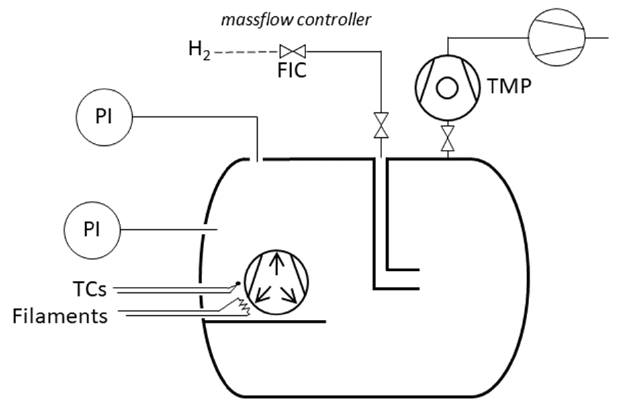
Figure 6. Schematic diagram of the TIMO facility with gas dosage, pressure gauges, auxiliary pumping system and the getter pump itself (with thermocouples (TC) and filaments).